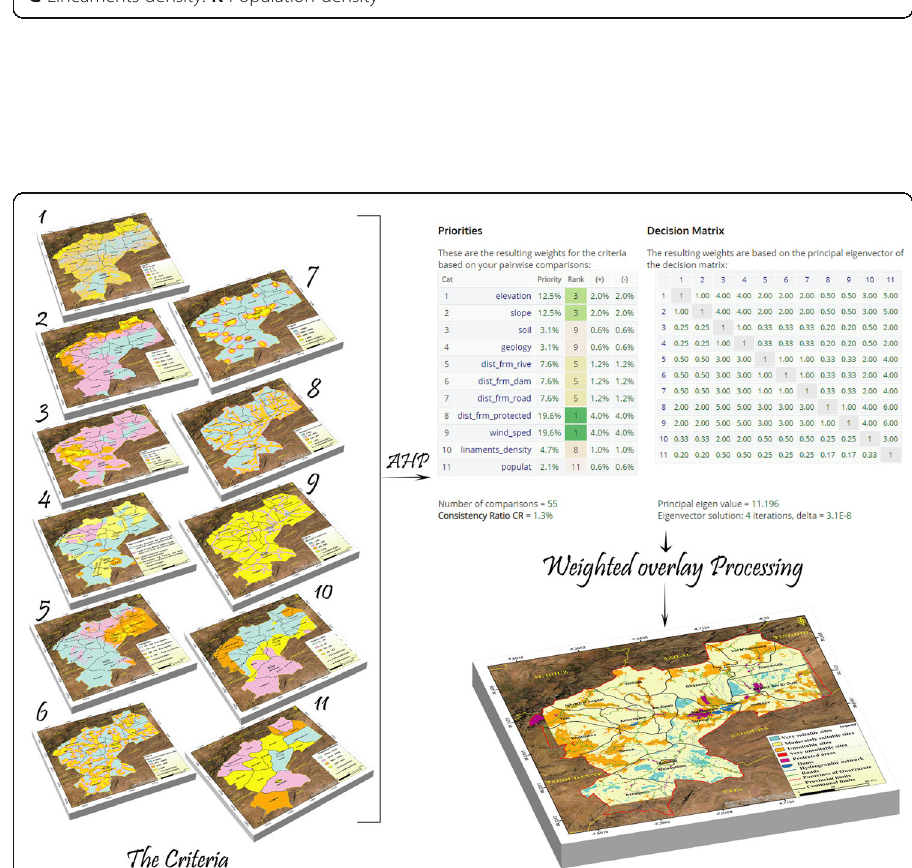
Fig. 11 Overlay of the raster data of the